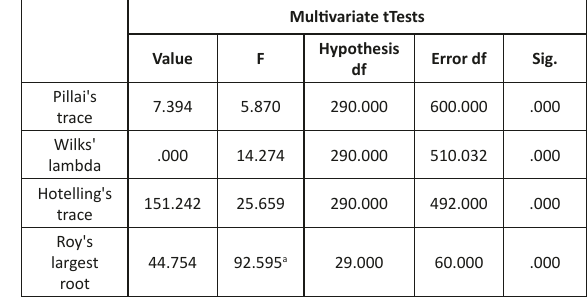
Table 5. MANOVA for Arothron & Lagocephalus from southeastern India.